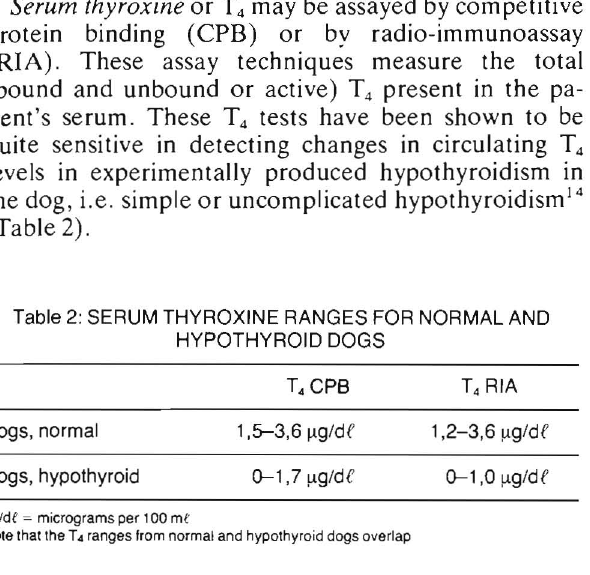
Fig. 3. A mixed breed dog, female, 10 years old, that had gained weight over the previous 4 months. Her hair coat was rough, and there was alopecia and hyperpigmentation in the flank area.